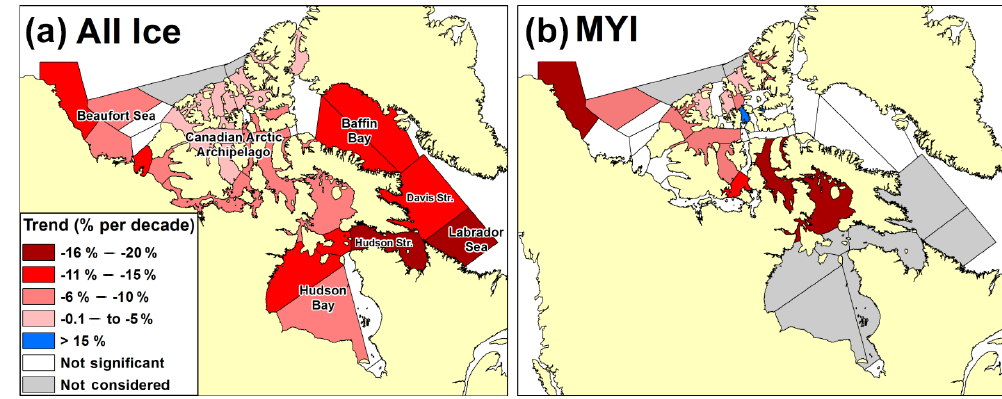
Figure 6. Trends in summer all ice (a) and multi-year ice (b) area from 1968 to 2016 from the CISDA. Only trends significant to the 95% confidence level are shown.